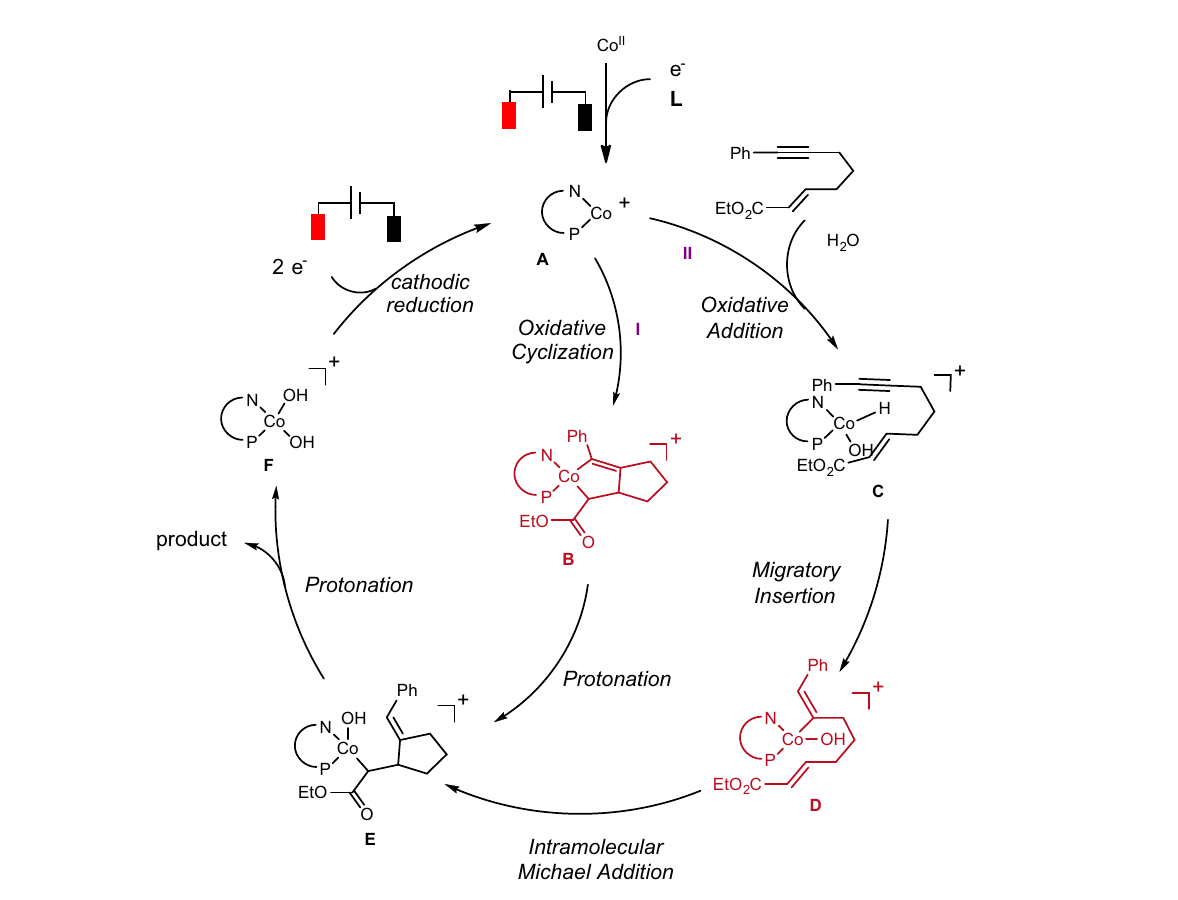
Fig. 4 | Proposed catalytic cycle. Two plausible different reaction pathways for reductive cyclization of